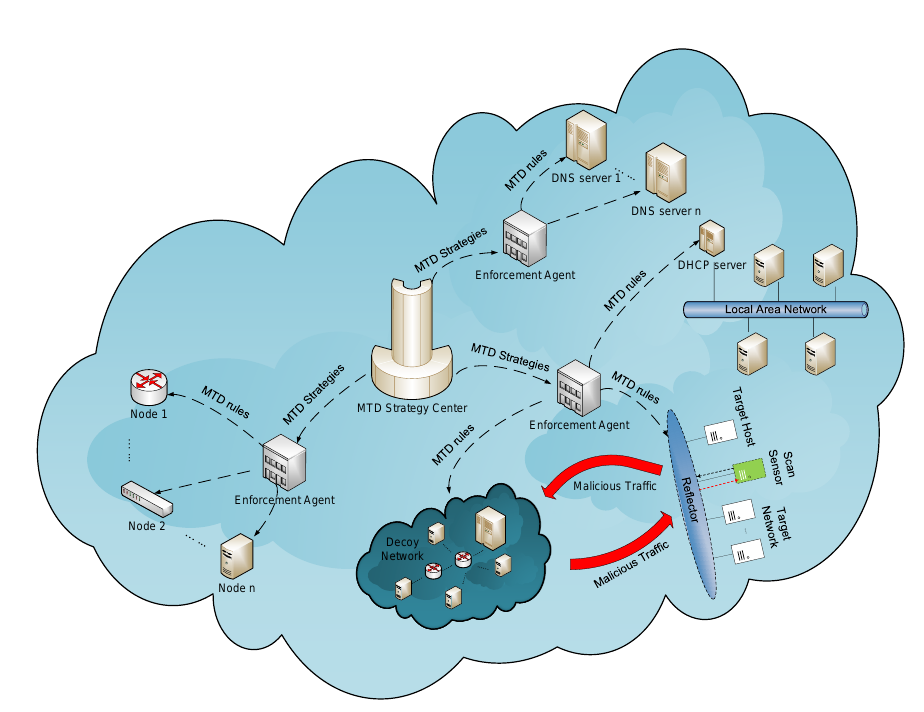
Figure 1. Shoal design and